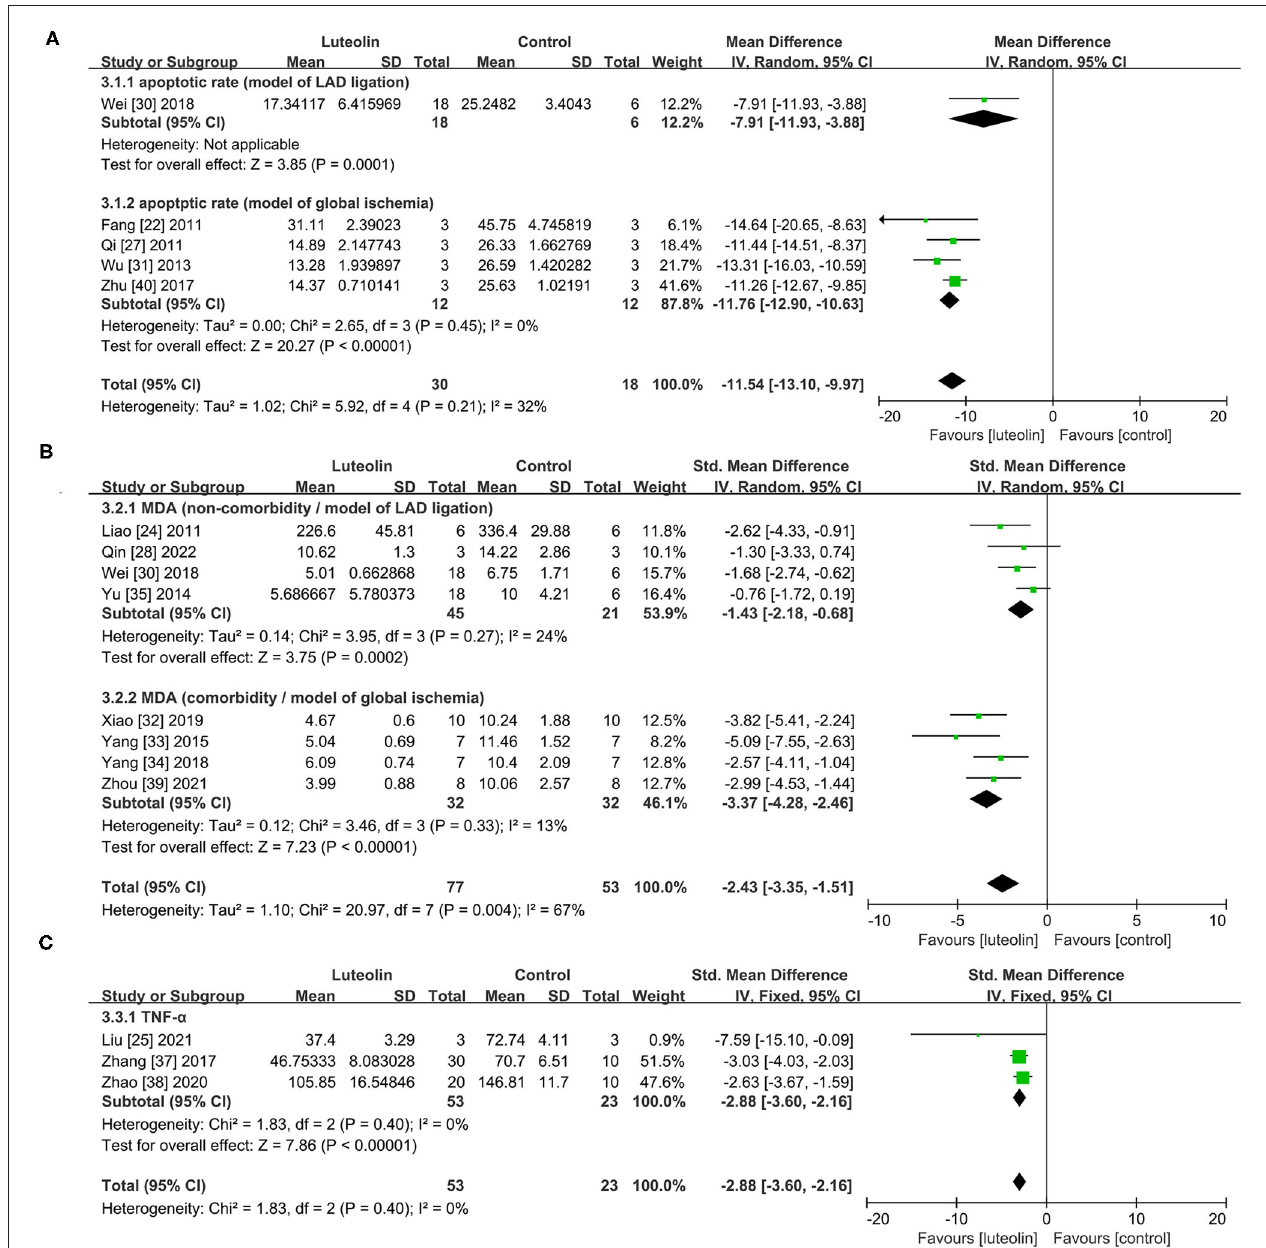
FIGURE 4 | Forest plots for (A) apoptotic rate, (B) MDA, (C) TNF- α . LAD, left anterior descending branch; MDA, malondialdehyde; TNF- α , tumor necrosis factor alpha.